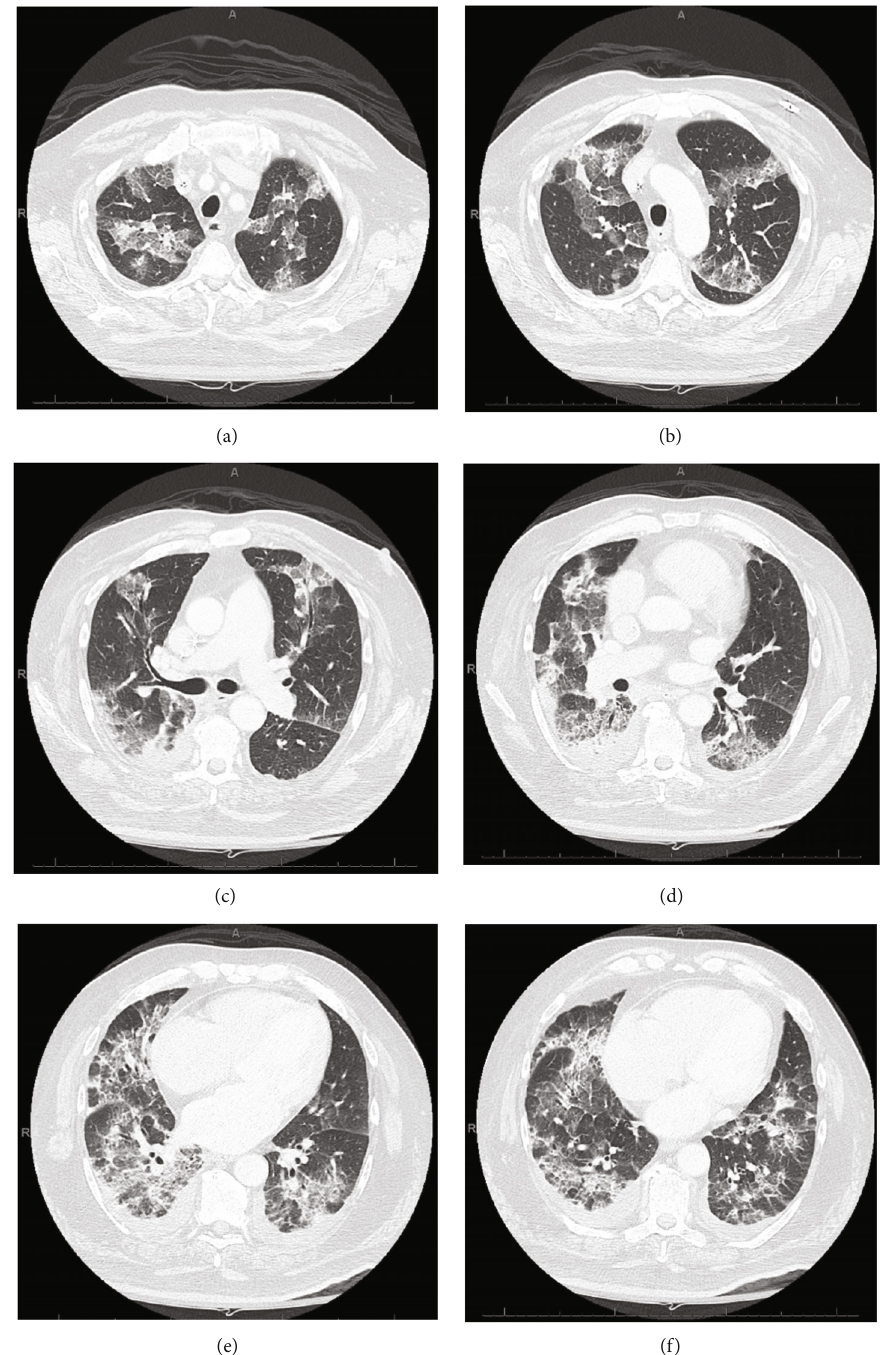
Figure 2: CT scan of the chest with intravenous contrast at day four of admission. CT chest images (a) – (f) showing patchy opacities of both lungs involving all lobes bilaterally (right greater than left) with some consolidation changes and mild bilateral pleural e ff